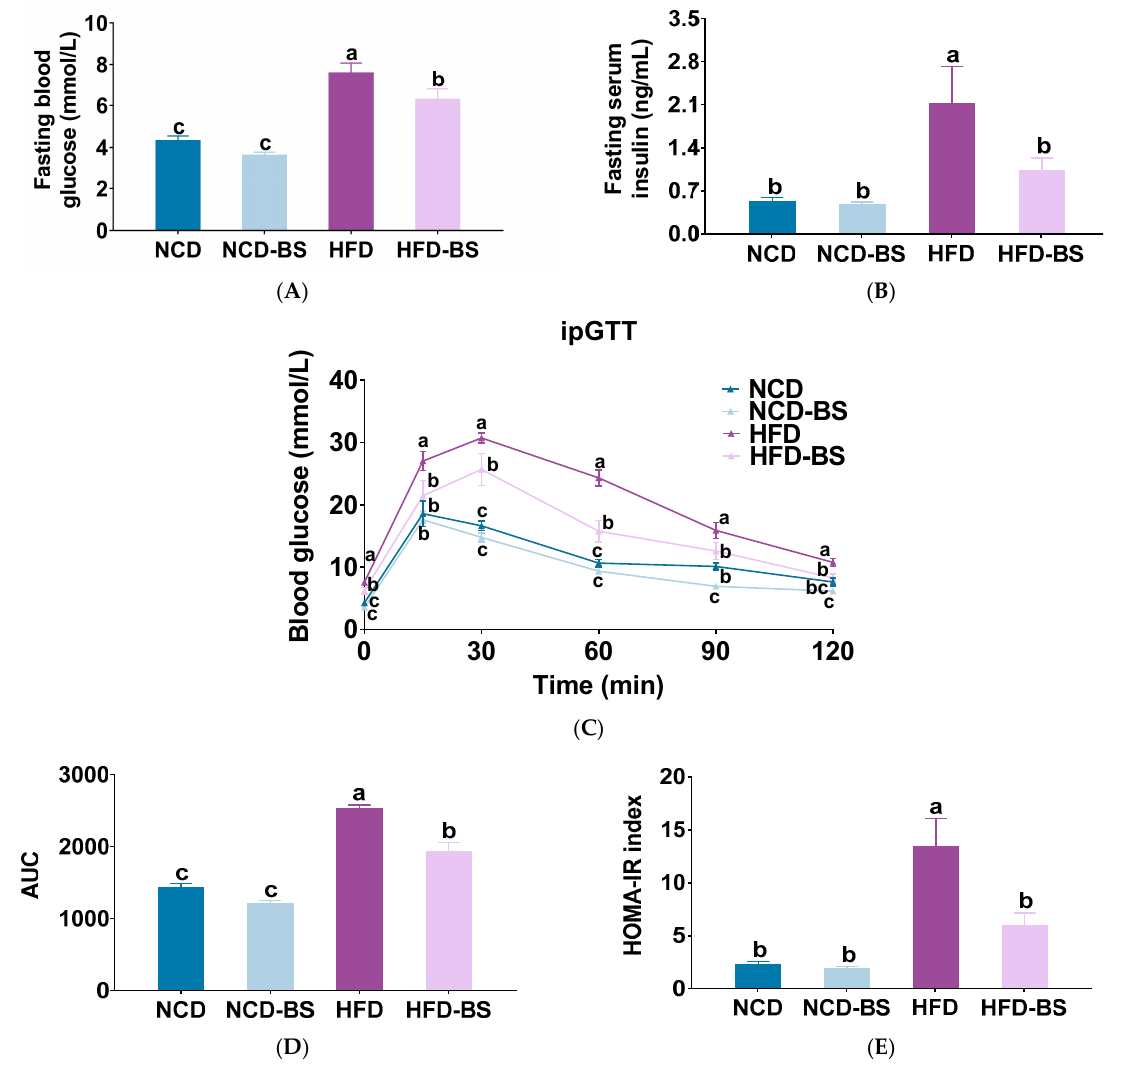
Figure 3. BS improved insulin resistance and glucose tolerance in HFD-fed mice. ( A ) Serum glucose, ( B ) serum insulin, and ( C ) blood glucose levels over time during the intraperitoneal glucose tolerance test (iPGTT); ( D ) homeo-static model assessment for insulin resistance (HOMA-IR) index, and ( E ) area under the curve calculation (AUC). Data are presented as mean ± SEM, n = 7. Means denoted by di ff erent le tt ers (a, b, c) indicate signi fi cant di ff erences between groups ( p < 0.05). NCD, normal control diet; NCD-BS, normal control diet supplemented with freeze-dried powder of bamboo shoots; HFD, high-fat diet; HFD-BS, high-fat diet supplemented with freeze-dried powder of bamboo shoots.